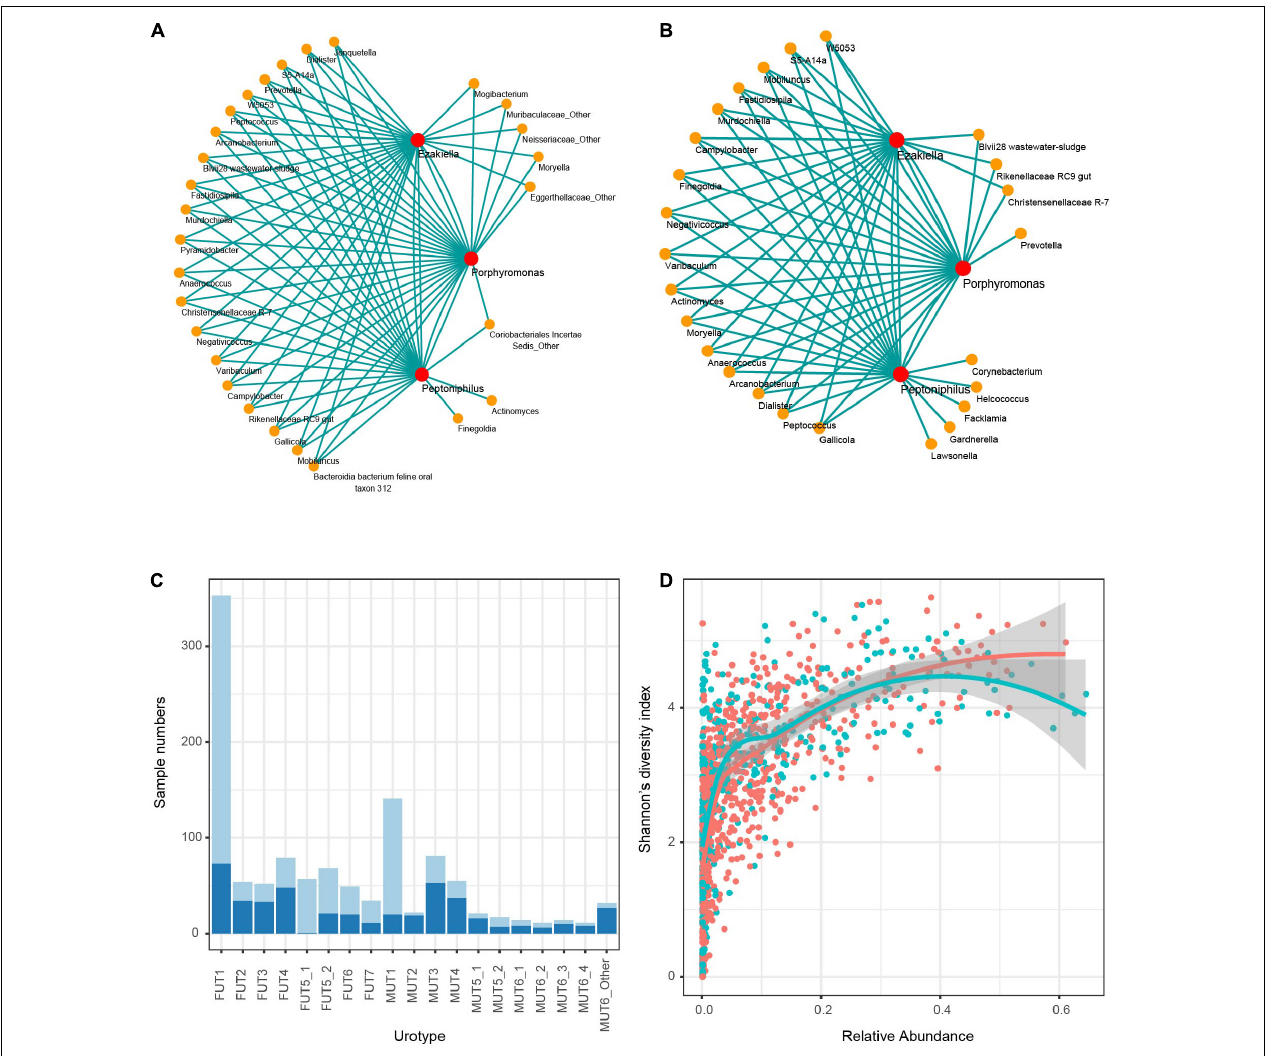
FIGURE 6 | Co-occurrence of Peptoniphilus , Ezakiella , and Porphyromonas . Network of co-occurring genera with Peptoniphilus , Ezakiella , and Porphyromonas based on Spearman correlation analysis for (A) male and (B) female samples, respectively. Lines connected two genera with Spearman |rho| > 0.35. (C) The proportion of samples harboring the co-occurred pattern in each urotype (light blue). (D) Correlation distribution of Shannon’s diversity index and relative abundance of the three co-occurred genera. Female and male samples were marked red and blue,